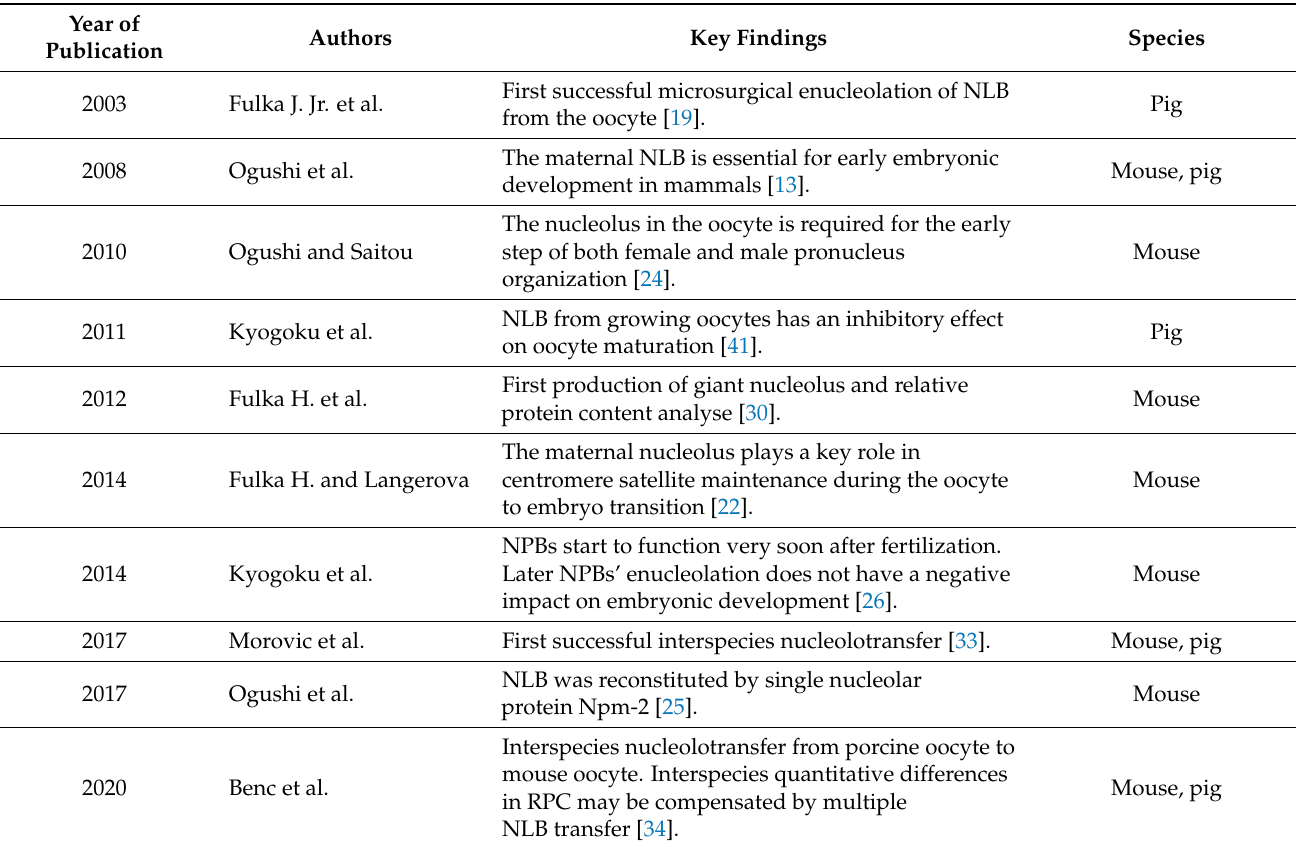
Table 2. Fibrillar sphere handling and finding